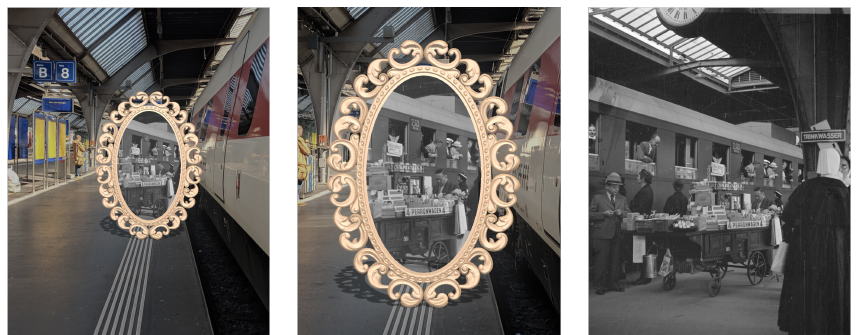
Figure 2. Portal perspectives. Left: Portal at a distance, Middle: Near the portal, Right: Inside the